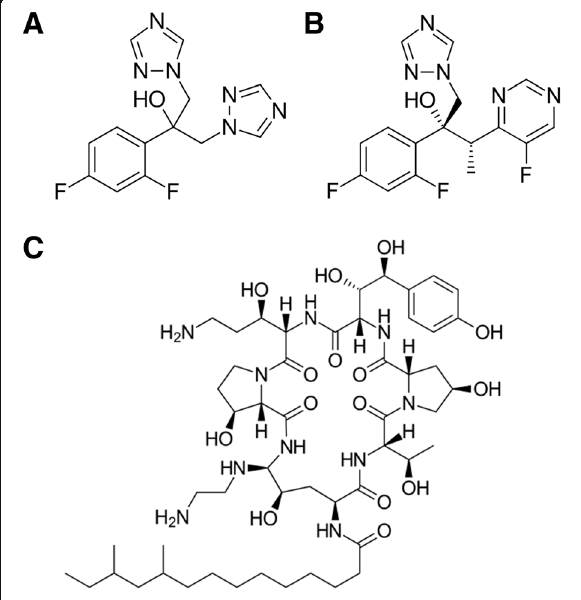
Fig. 2 Structural formula of fluconazole ( a ), voriconazole ( b ) and caspofungin ( c